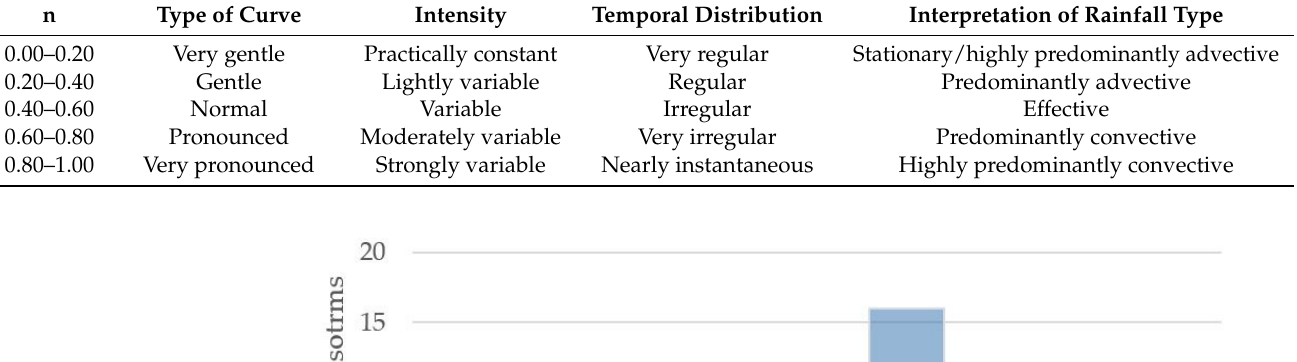
Table 2. Storm classification according to intensity regularity vs. time. Adapted from Refs. [37,38].